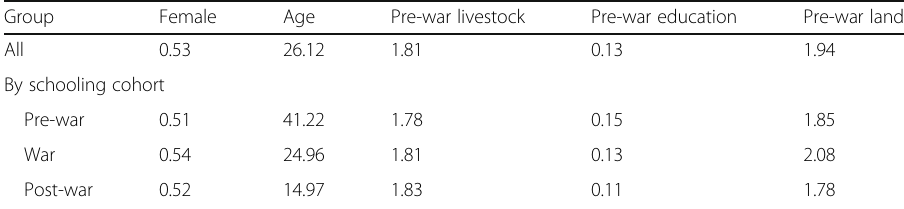
Table 3 Descriptive statistics of the control variables